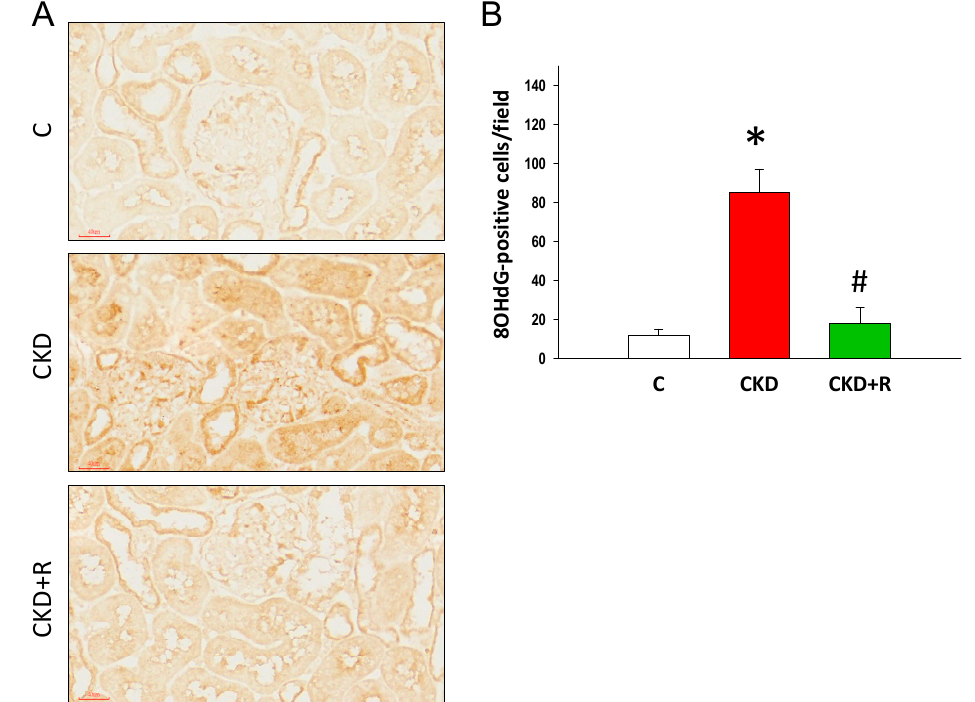
expression in the o ff spring’s kidneys; Bar = 40 µ m. ( B ) Quantitative analysis of 8-OHdG-positive cells Figure 8. (A) Representative light micrographs illustrating 8-hydroxy-2 ′ -deoxyguanosine (8-OHdG) per microscopic field; * p < 0.05 vs. C; # p < 0.05 vs. expression in the offspring’s kidneys; Bar = 40 μ m. (B) Quantitative analysis of 8-OHdG-positive cells per microscopic field; * p < 0.05 vs. C; # p < 0.05 vs. CKD.